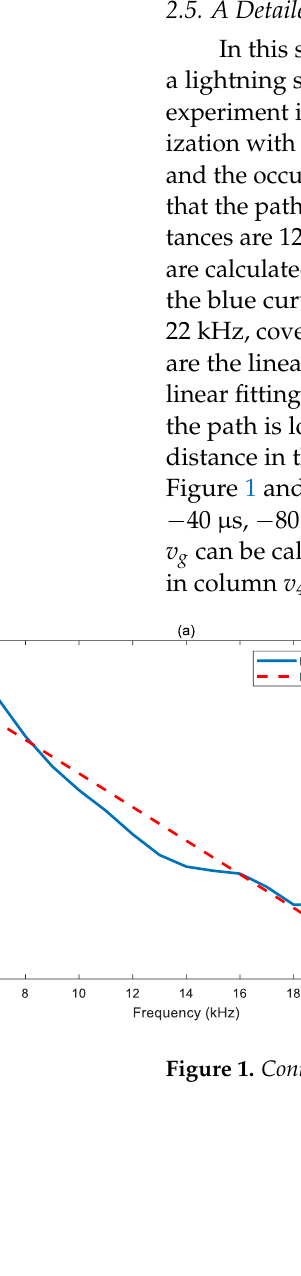
Figure 1. The calculated phase-versus-frequency curves (blue) and the corresponding linear fitting lines (red dotted). ( a – d ) correspond to four paths from lightning source to the stations. Table 2 also presents the intermediate and final results of the calculation of the group velocity of the first-order mode and the group velocity estimated by LWPC only, which are defined as v 2 and v 3 and are described in detail in Section 3.1. The calculation process of v 3 is similar to that of v 4 , and will not be repeated here. For v 2 , the calculation results include the average ionospheric reflection height h’ , the phase velocity v p, and the group velocity v g , as shown in column v 2 of Table 2. Table 2. Intermediate and final calculation results of different methods of group velocity estimation. Station